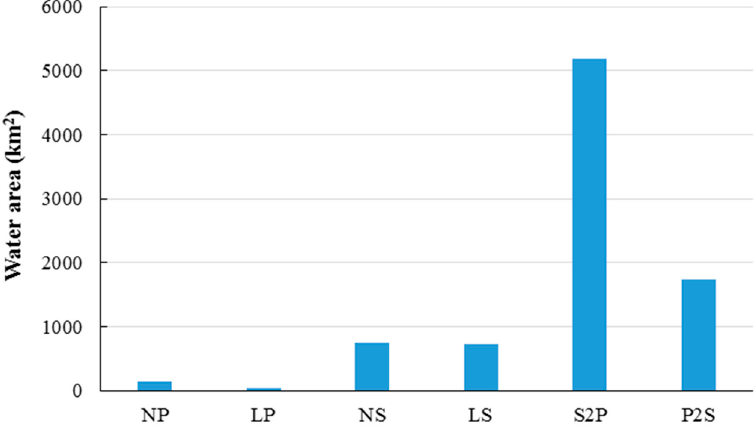
Figure 10. Change in seasonal and permanent water 2001–2015 in YRB.